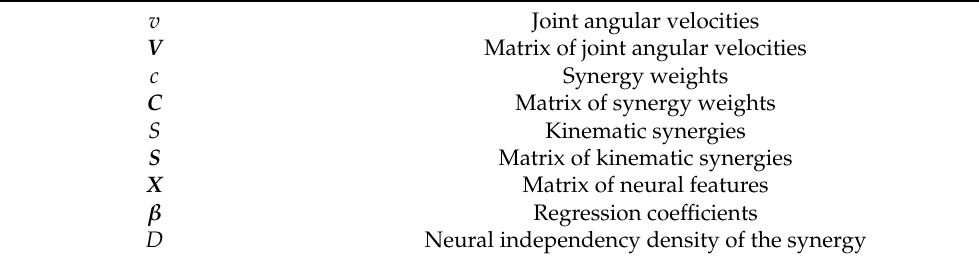
Table 1. Nomenclature table (symbols and